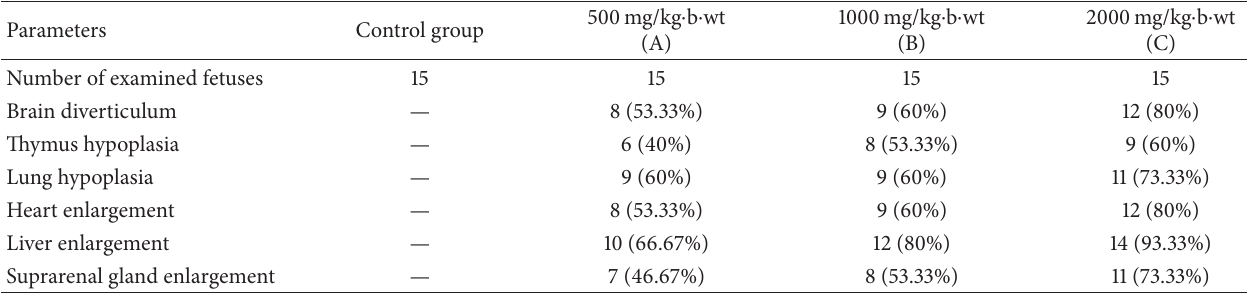
Table 2: Visceral abnormalities in fetuses obtained from pregnant female rats after repeated oral administration of 500, 1000, and 2000